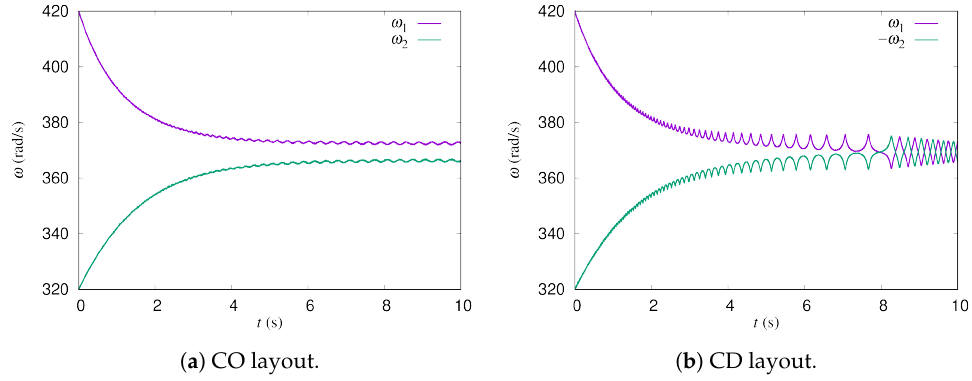
Figure 8. Time evolution of ω i for the ( a ) CO and ( b ) CD layouts with α = 0.1 and g 12 = 10mm when the rotor torque of rotor 2 is 95% that of rotor 1. The induced velocities are not taken into